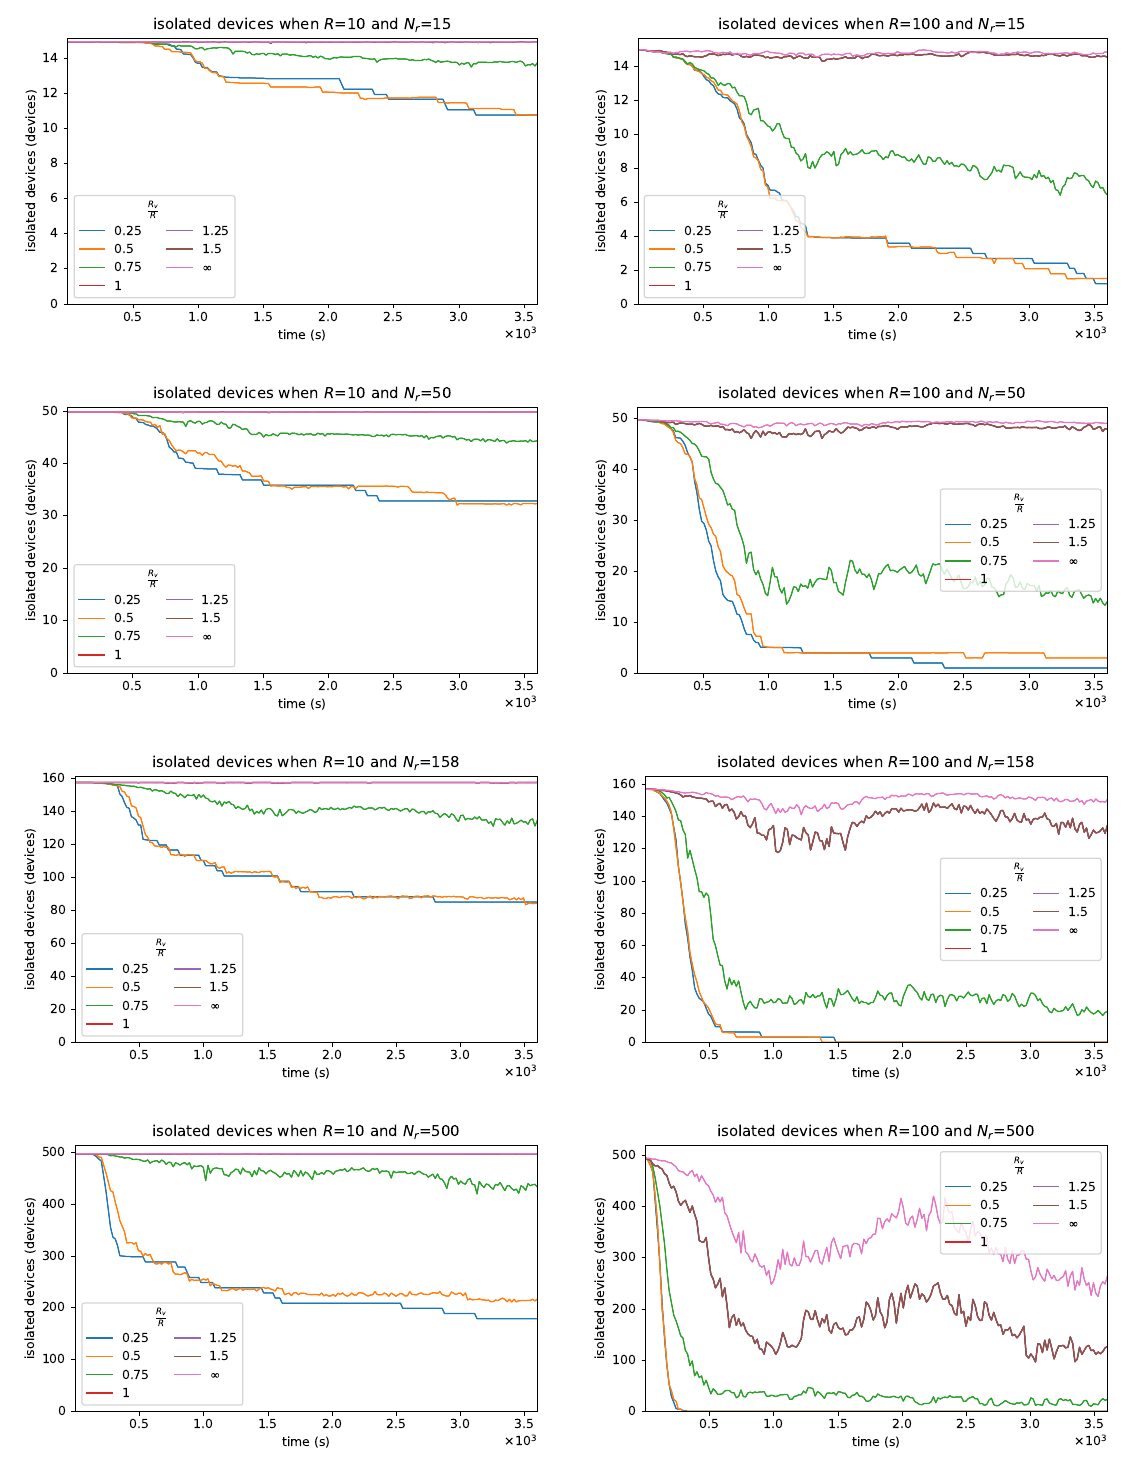
Figure 7. System performance measured as count of isolated devices I for communication range R = 10 m ( left column ) and communication range R = 100 m ( right column ), and increasing count of explorers N r ( top to bottom ). As expected, systems that generate virtual devices more densely achieve better coverage. With many explorers, the benefits of a denser generation lower. Even with few explorers, there is little difference between R v R = 0.25 and R v R = 0.5, confirming the results seen in Figure